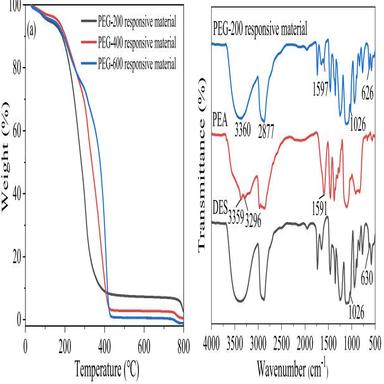
(a) TGA curves for CO2-responsive phase transfer materials (PEG-200, 400, 600); (b) FT-IR spectrum of CO2-responsive phase transfer materials (PEG-200).